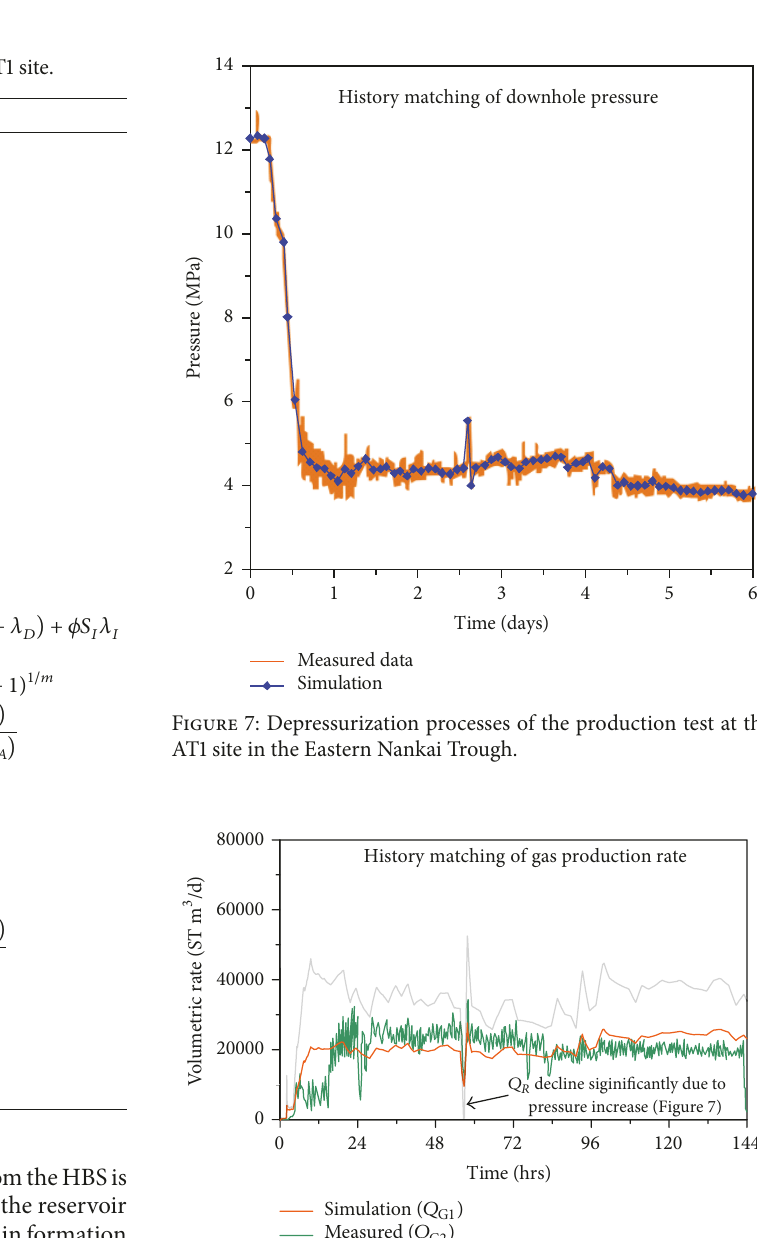
Figure 10 indicates the evolution of the simulated 𝑅 CWG during the 6-day production test at the AT1